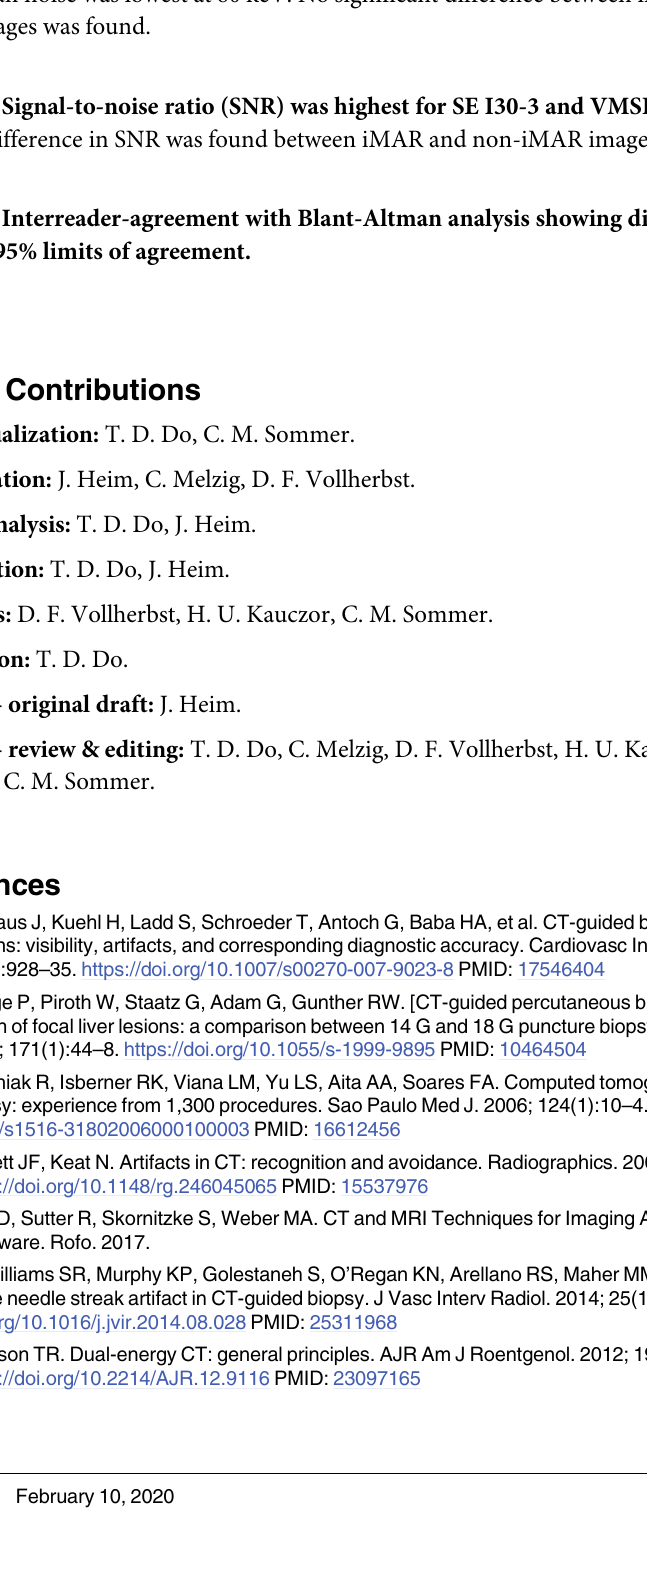
S3 Table. HU values for inferior vena cava (IVC) and liver parenchyma considering the axial slice without any visible artifacts. S4 Table. Noise measured in the liver parenchyma on an axial slice without any visible arti- facts. Mean noise was lowest at 80 keV. No significant difference between iMAR and non- iMAR images was found. S5 Table. Signal-to-noise ratio (SNR) was highest for SE I30-3 and VMSI at 80 keV. No sig- nificant difference in SNR was found between iMAR and non-iMAR images. S6 Table. Interreader-agreement with Blant-Altman analysis showing difference and in brackets 95% limits of